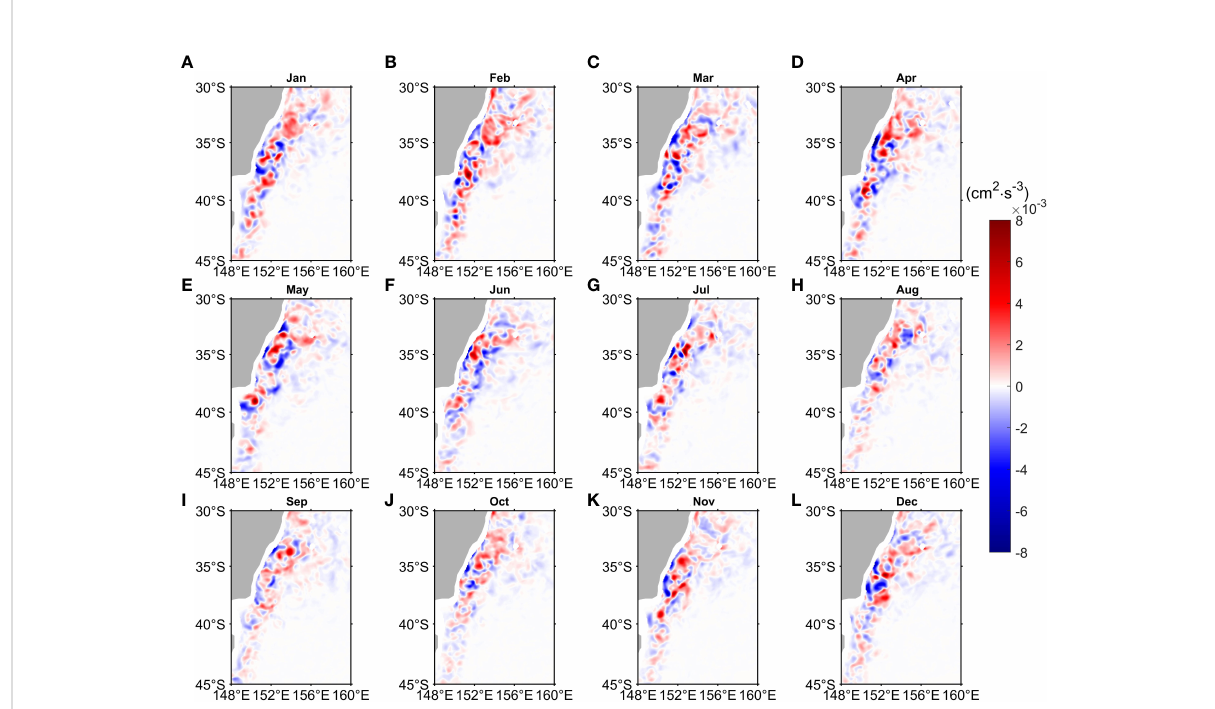
FIGURE 6 Monthly mean barotropic conversion rate (BTR, Unit: cm 2 s -3 ) distribution averaged over the upper 300 m layer from OFES during July 1999- October 2009 for (A) January, (B) February, (C) March, (D) April, (E) May, (F) June, (G) July, (H) August, (I) September, (J) October, (K) November and (L) December. BTR is de fi ned in Eq. (3).